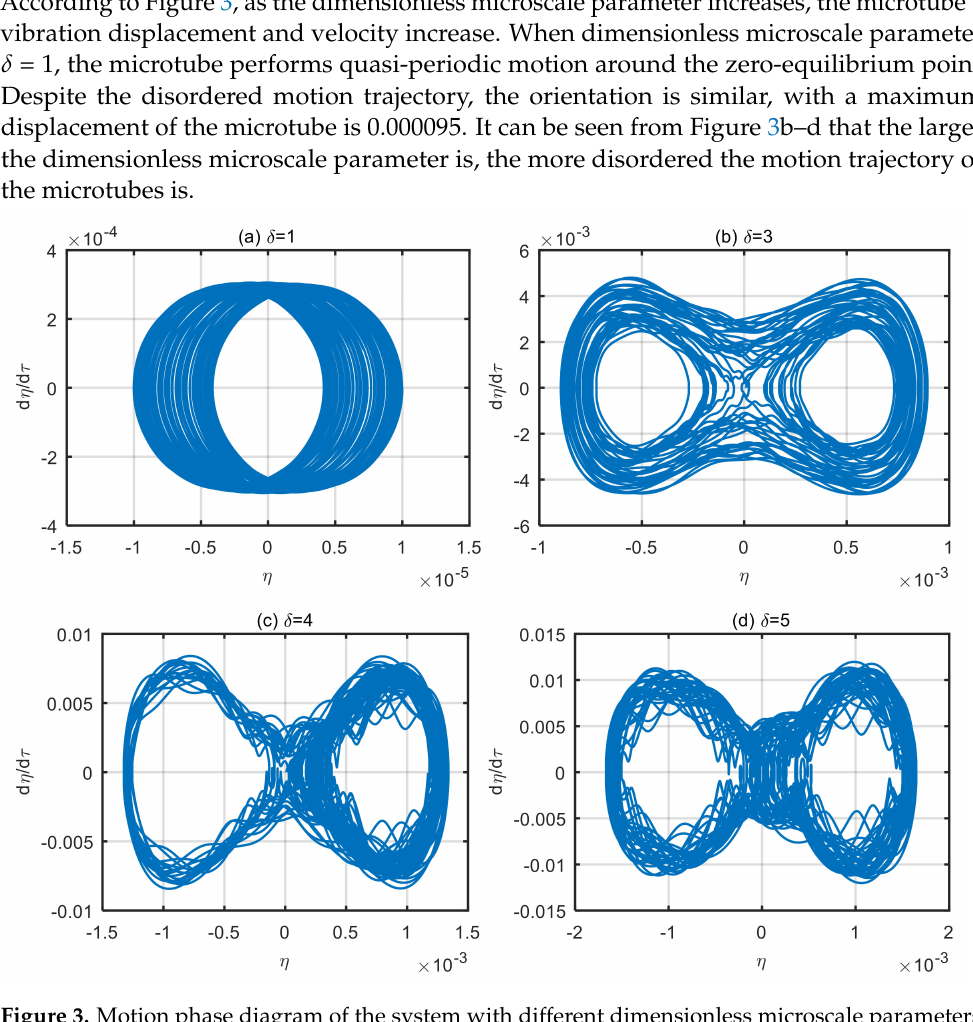
Figure 3. Motion phase diagram of the system with different dimensionless microscale parameters. ( a ) δ = 1; ( b ) δ = 3; ( c ) δ = 4; ( d ) δ =